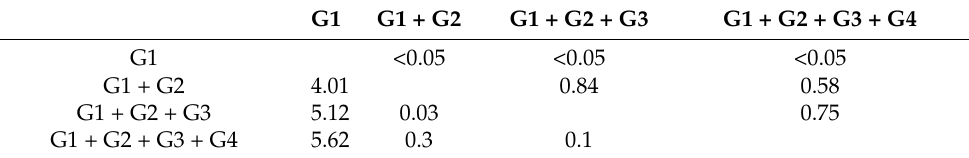
Table 4. Matrix of McNemar test showing the statistical significance of differences between all variable sets. McNemar’s test values ( χ 2 ) are on the left side of the diagonal, p -values on the right side.